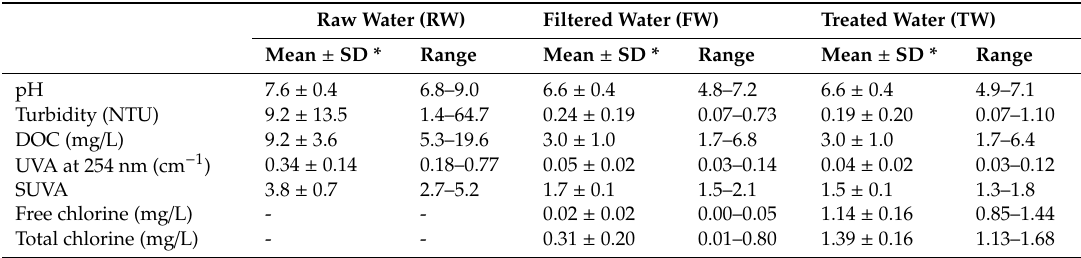
Table 3. Water quality characteristics at the study area water treatment plant (WTP) between June and August 2016 (n = 91).